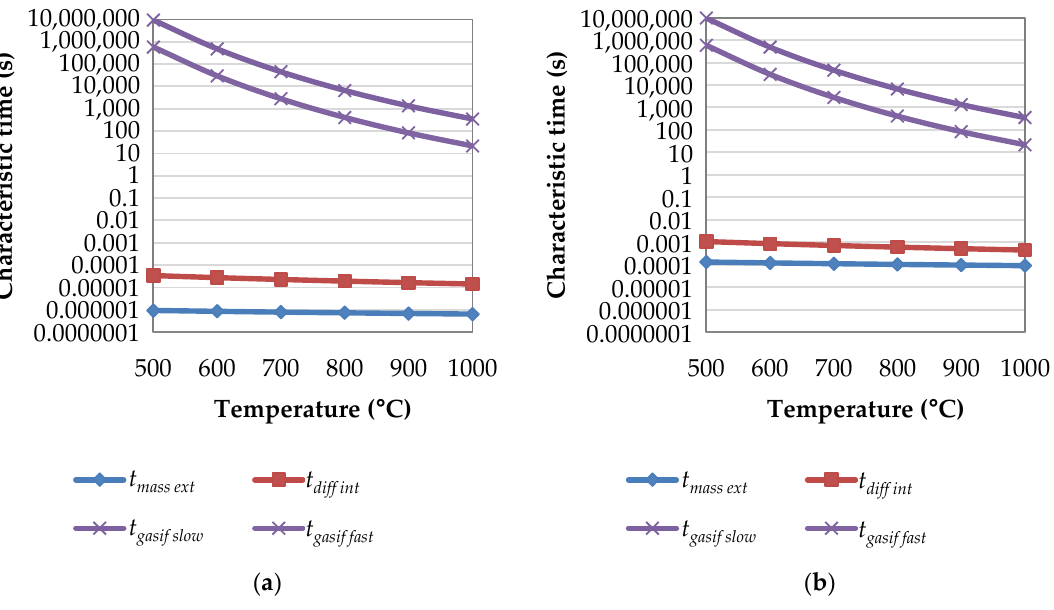
Figure 4. Characteristic times of the gasification step as a function of temperature for TGA conditions at: ( a ) particle scale and ( b ) bed scale.